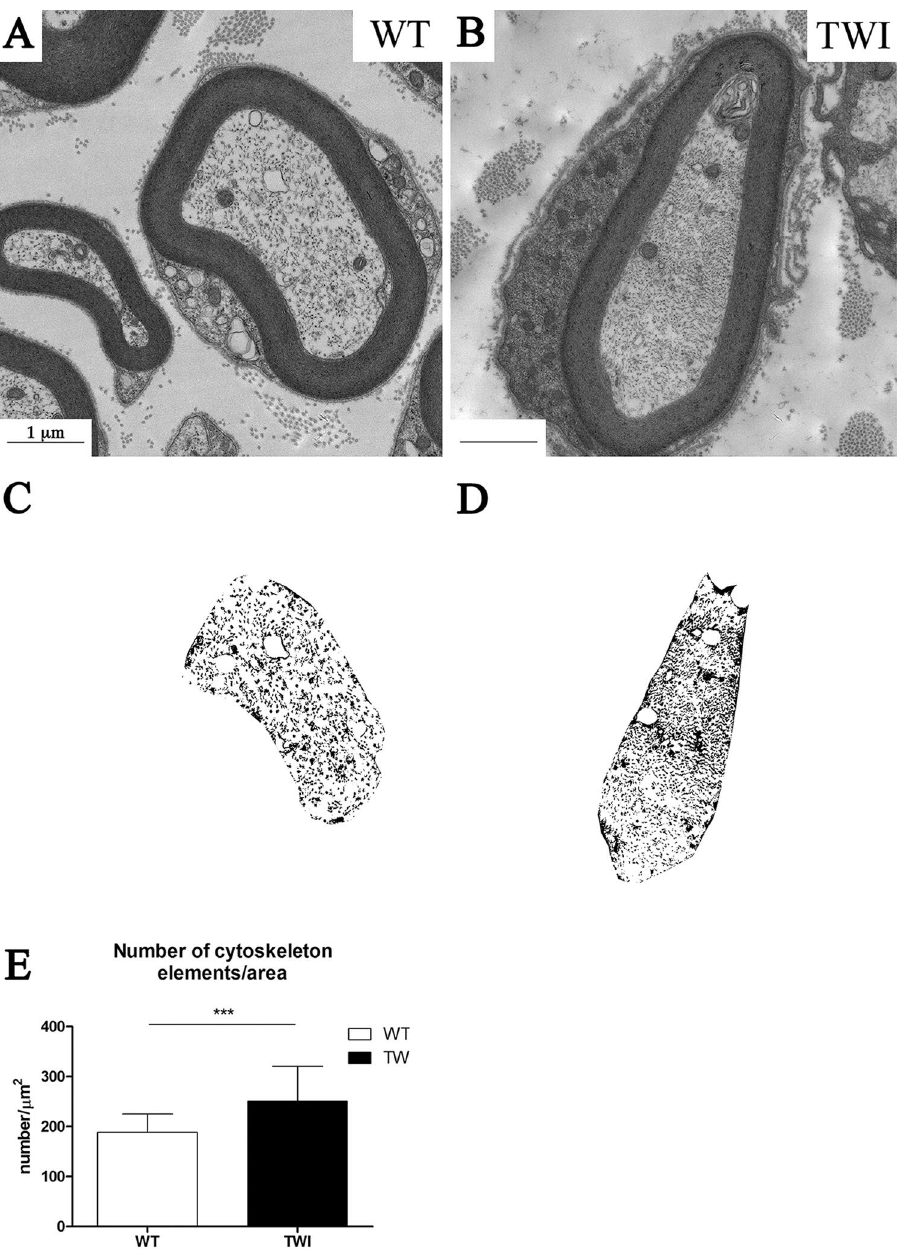
Figure 2. Axonal cytoskeleton density is increased in P30 TWI mice sciatic nerves. ( A,B ) bright field images of representative axons in WT ( A ) and TWI ( B ) sciatic nerves. ( C,D ) bitmaps obtained with the semi-automated method to compute axonal cytoskeleton density from the images in A and B, respectively. ( E ) Quantification of cytoskeleton elements